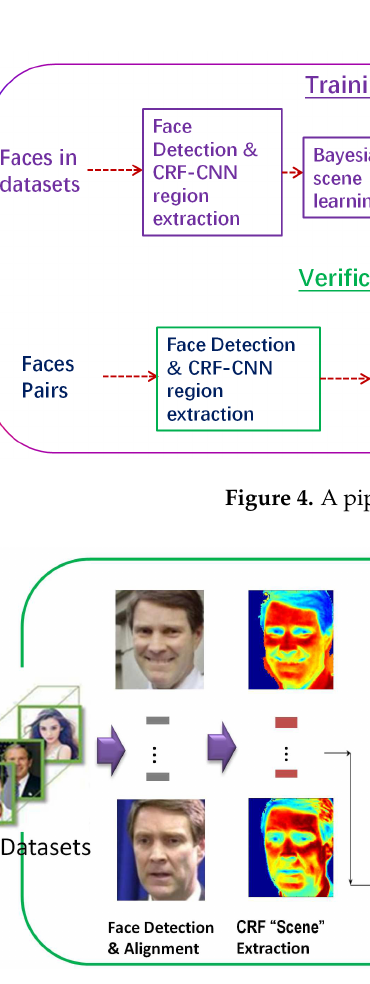
Figure 5. A brief view of the scene learning